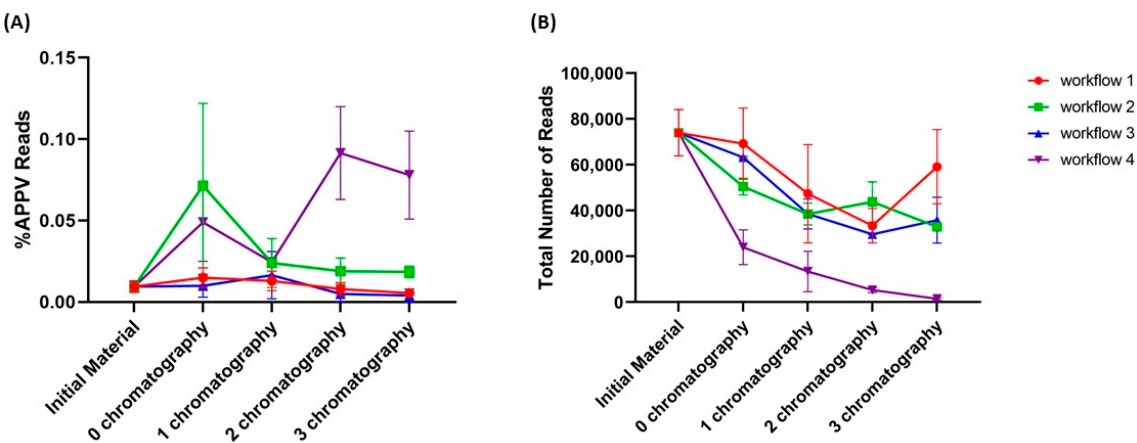
Figure 1. Effect of the novel semi-high-throughput processing workflows on the ( A ) percentage of viral reads and ( B ) total number of reads after each Capto™ Core 700 chromatography round.